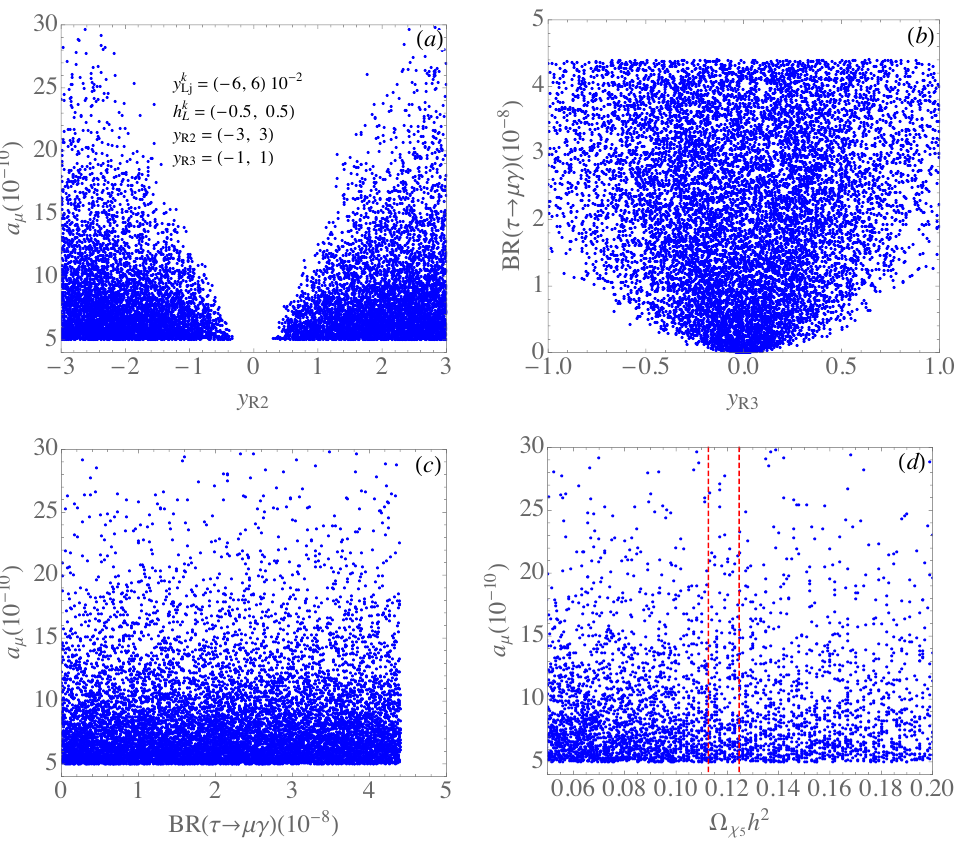
Figure 7 . Scatter plots for the correlation between (a) a µ and y R 2 , (b) BR( τ → µγ ) and y R 3 , (c) a µ and BR( τ → µγ ) , and (d) a µ and Ω DM h 2